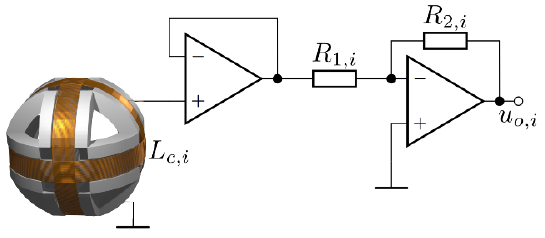
Figure 5. Input buffer and amplifier.